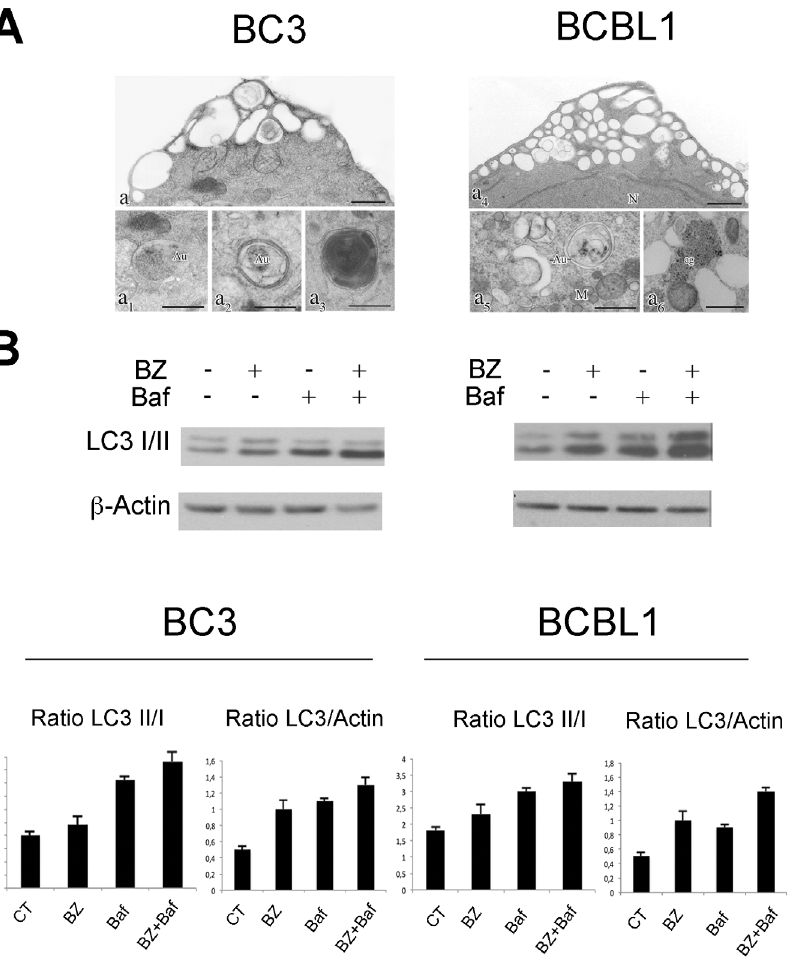
Figure 2. Bortezomib induces autophagy in PEL cells. (A) Electron microscopy (EM) on BC3 and BCBL1 cells treated with 20 nM of bortezomib after 16 hrs shows pronounced cell vacuolization (A a, a 4 ) with autophagosome membrane-bound compartment in different stage of maturation (A a 1, a 2 , a 4, a 5 ). Small intracellular structures consistent with aggresomes were evident in BCLB1 cells (A a 6 ). N (Nucleus), Au (Autophagosomes), M (Mitochondria), ag (aggresomes). Bars 1 m m. Results are representative of three independent experiments. (B) PEL cells were treated with bortezomib (20 nM), bafilomycin A (Baf) (10 nM) or combination of both. The western blot analysis was performed to detect the two isoforms of LC3 protein. The histograms indicate LC3-II/I and LC3-II/Actin ratio based on densitometric analysis (mean 6 the standard deviation, n=3 experiments). An antibody against b -actin was used as loading control.